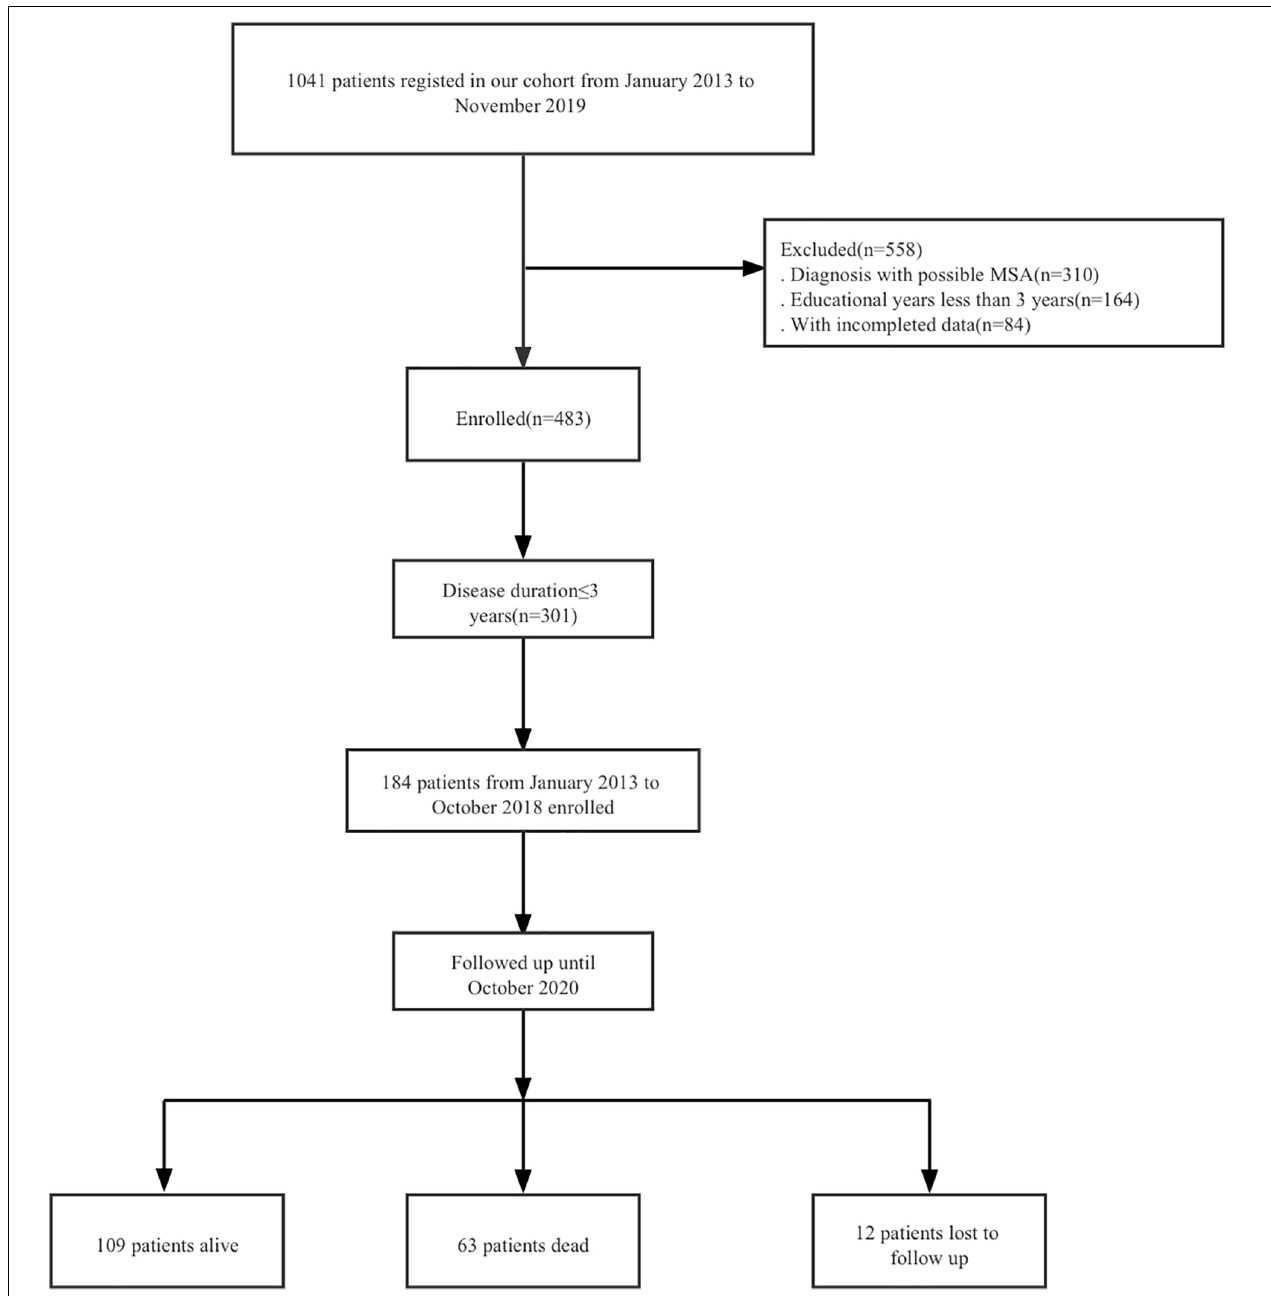
FIGURE 1 | Study flow